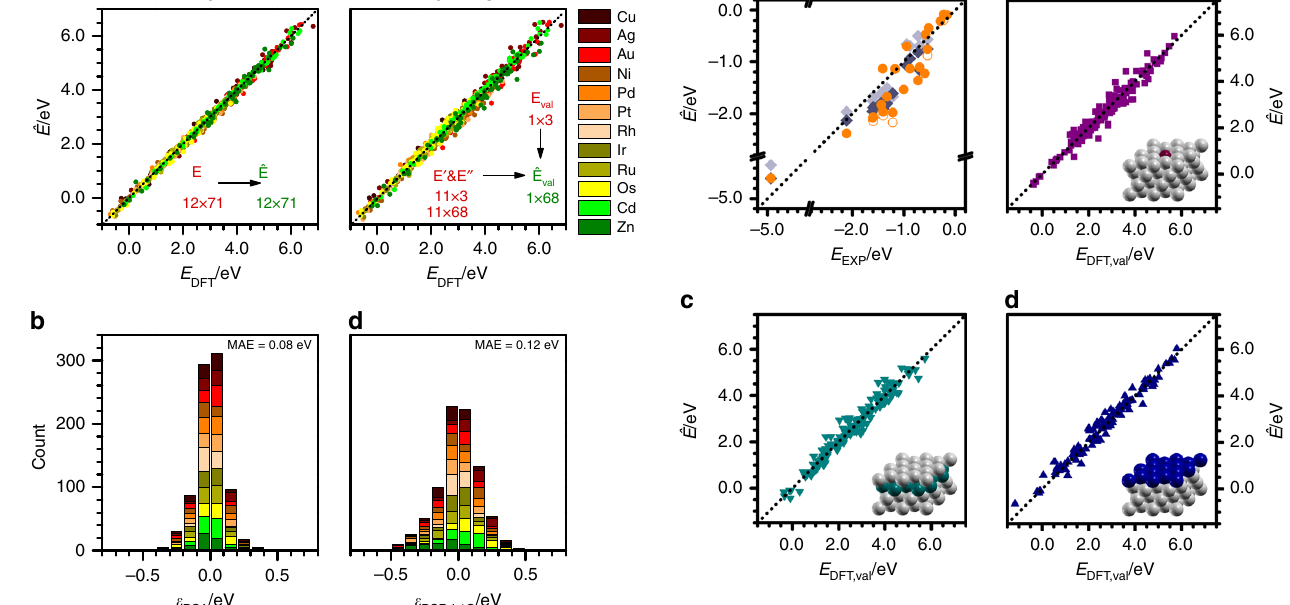
The adsorption energies of metals that are better predicted correspond to Rh and Ir with 0.05 and 0.08 eV MAE, whereas the worst are Zn and Ag with 0.18 and 0.17 eV MAE. Zn (Ag) has the more exothermic (endothermic) average of formation energies.